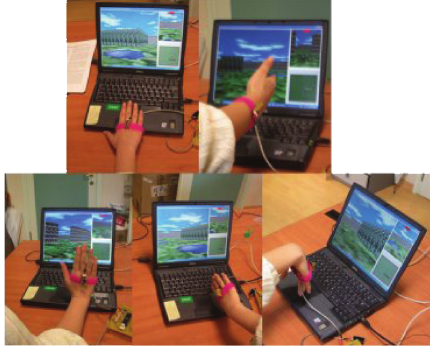
Figure 7: A set of screen captures of the virtual world, as seen from an LCD while a user is interfacing with it through MOCA.